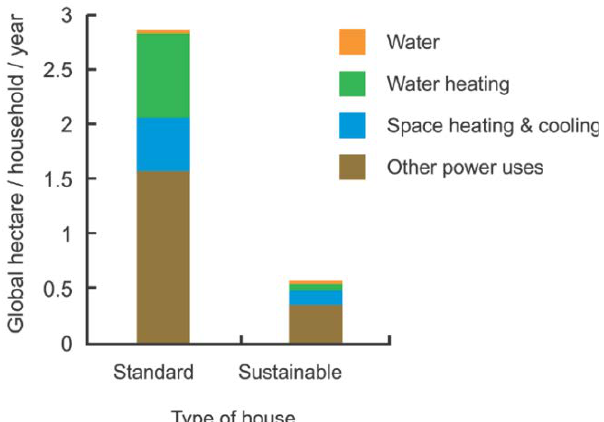
Figure 3: House footprint results - average across 35 typical project home designs (Divecha, Muffet & Grant